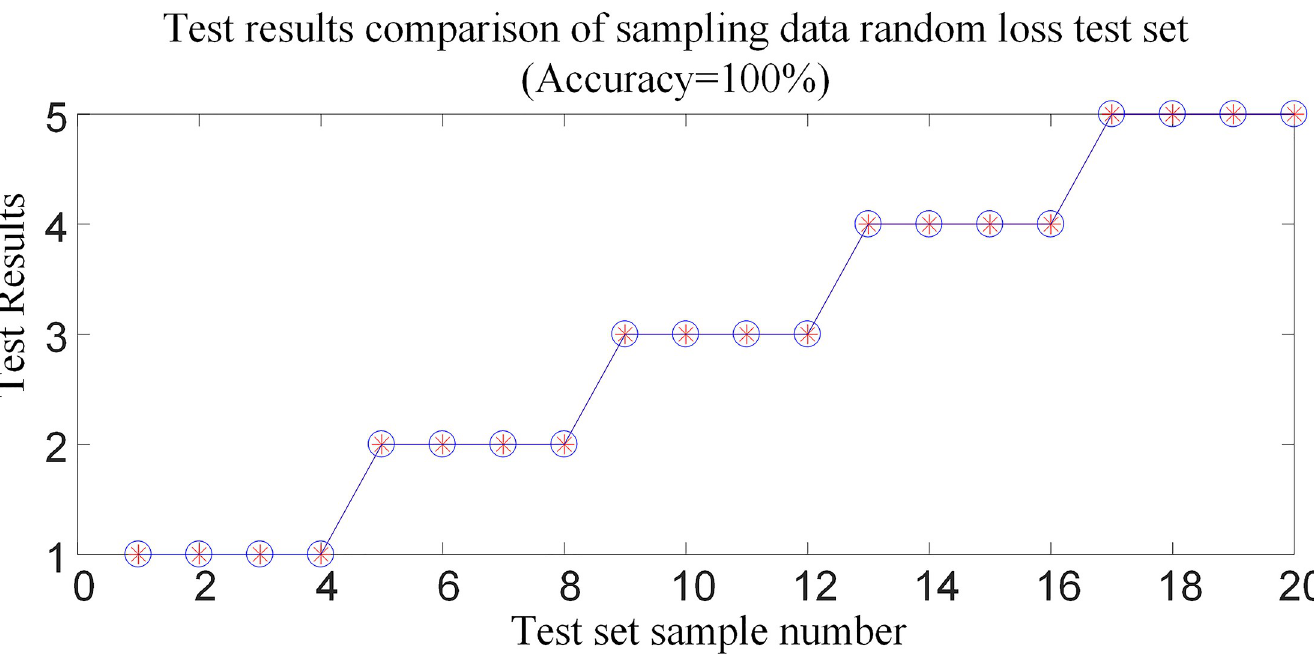
Fig 20. Sample data loss randomly (10~40 data) recognition result.